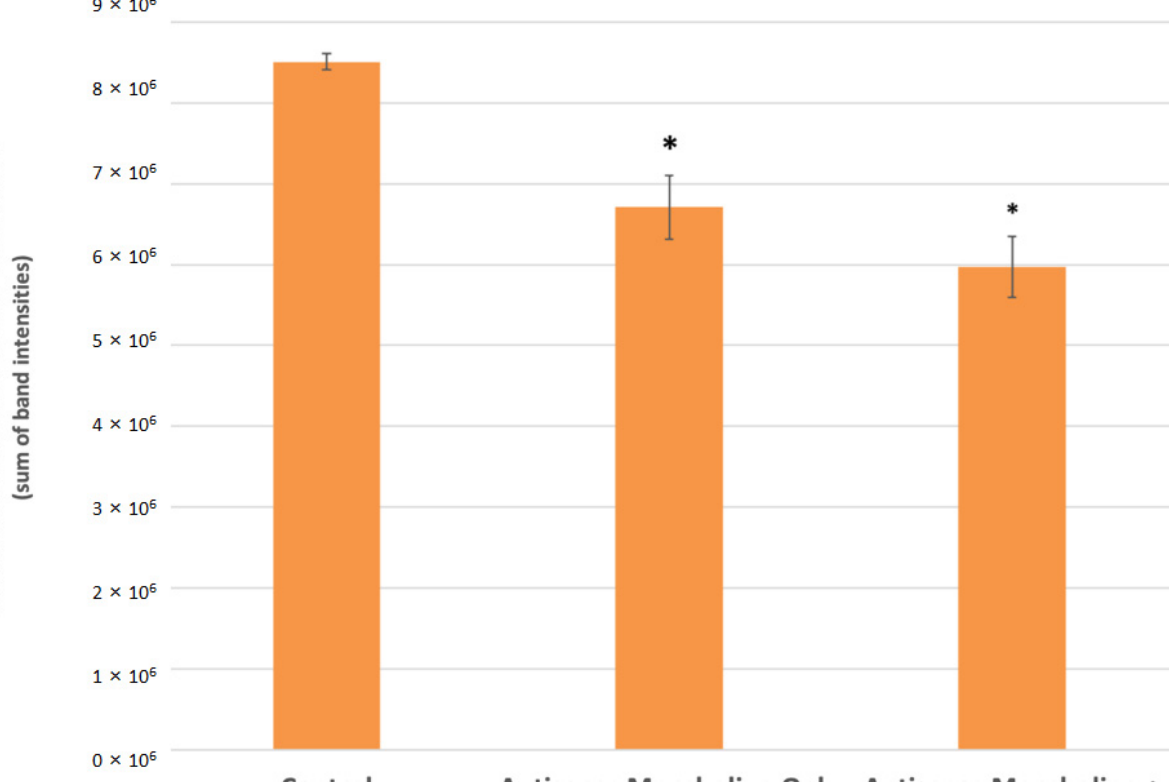
Figure 4. Western blot analyses for eIF4E-1a concentrations within control and treated cells at 48 h post-MO [1 µ M] addition (N = 3). Protein loading and relative expression levels was verified by probing with anti-eIF4E-1a mouse monoclonal and HRP-conjugated an-ti-mouse IgG. eIF4E-1a Protein area volumes were reduced by 30% after introduction of custom translation blocking morpholino and Endo Porter after 48 h. Statistical analy-sis was done using t -tests with pooled standard deviations. * Significantly different from “Control” based on a p -value of < 0.05. No significant difference found between “Antisense Morpholino Only” and “Antisense Morpholino + Endo Porter” based on a p -value of <